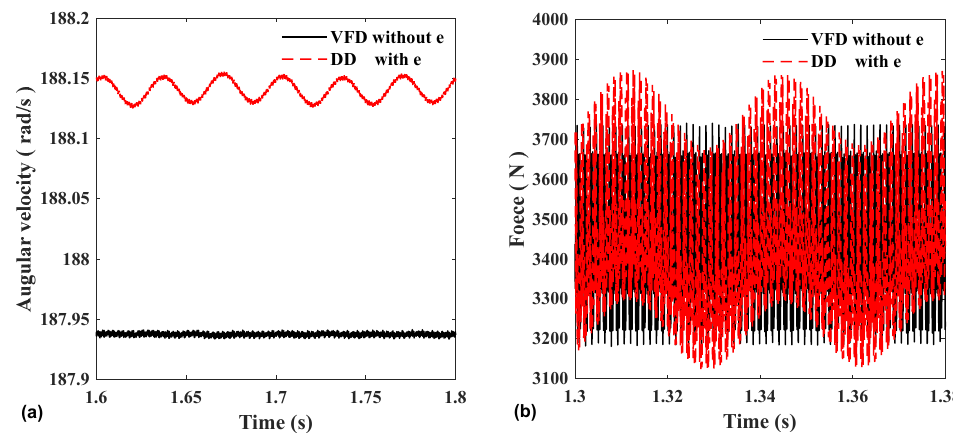
Figure 17. ( a ) Gear 1 angular velocity and ( b ) gear 1–3 mesh force.